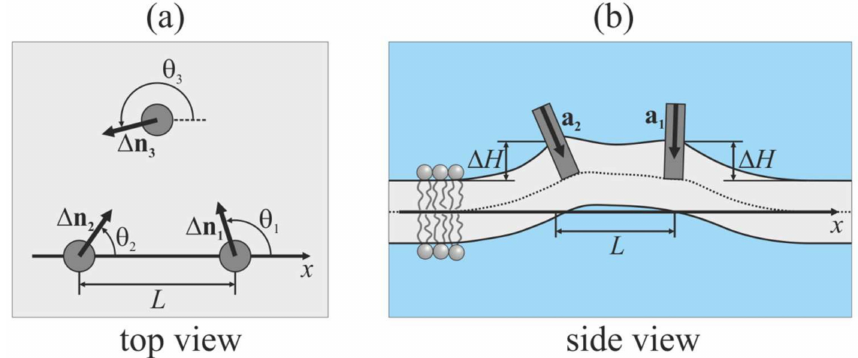
Figure 3. Schematic illustration of configuration of peptides embedded into the upper monolayer of the membrane (shown by light gray color). ( a ) Top view; ( b ) side view. Embedded peptides are shown as gray circles (panel ( a )) or gray rectangles (panel ( b )). a is the unit vector directed along the longitudinal peptide axis; ∆ n is the projection of a onto the Oxy plane; θ is the angle between the Ox axis and ∆ n; L is the distance between peptides; ∆ H is the vertical position of center of the peptide intersection with the neutral surface of the upper monolayer relative to the position of this surface far from embedded